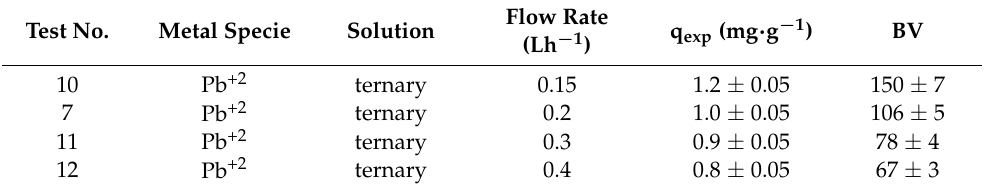
Figure 7. ( A ) Breakthrough curves in distilled water for lead ions in ternary solutions. Measurements were carried out at 0.15, 0.2, 0.3, and 0.4 Lh − 1 flow rate, 2 mg Pb +2 L − 1 , 10 g RWPG, 0.5–1 mm bead size range, pH = 6, and T = 298 K). ( B ) Time-dependent breakthrough curves. ( C ) Correlation of the half exchange time and t 0.5 (C/C 0 = 0.5 in the breakthrough curves) vs. flow rate. Table 5. Sorption parameters for multimetal solutions of lead, cadmium, and nickel ions at different flow rates. Measurements carried out with 2 mg Me +2 L − 1 , 10 g RWPG, 0.5–1 mm bead size range, and T = 298 K.